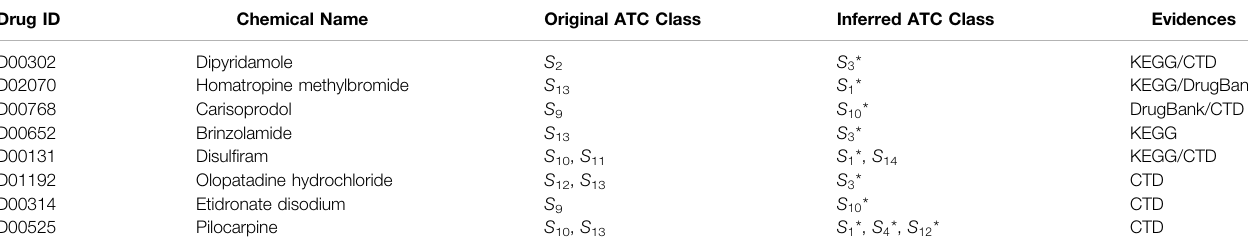
TABLE 7 | Eight inferred drugs ATC class based on the DACPGTN model. Drug